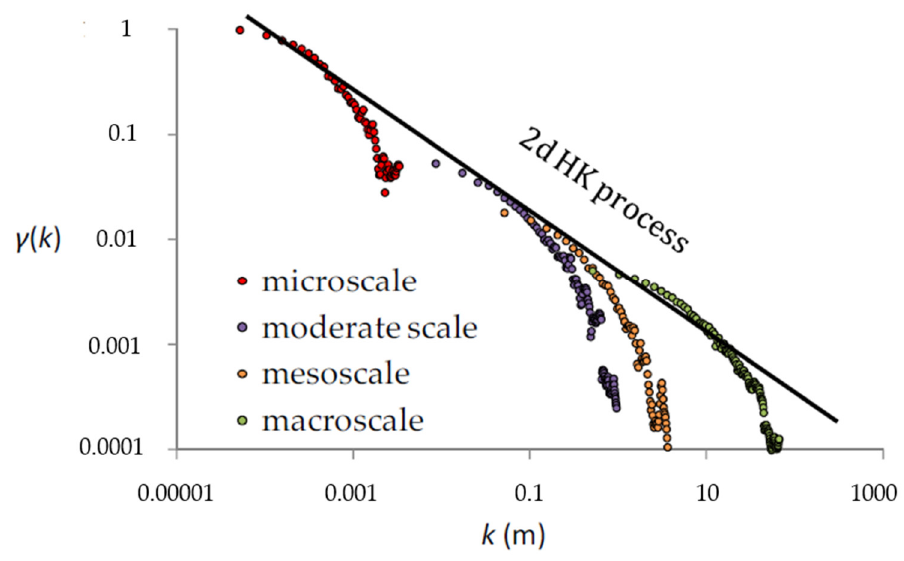
Figure 8. Standardized climacograms of sandstone images depicted at four different scales and the fitted 2D HK model (source: [32]).